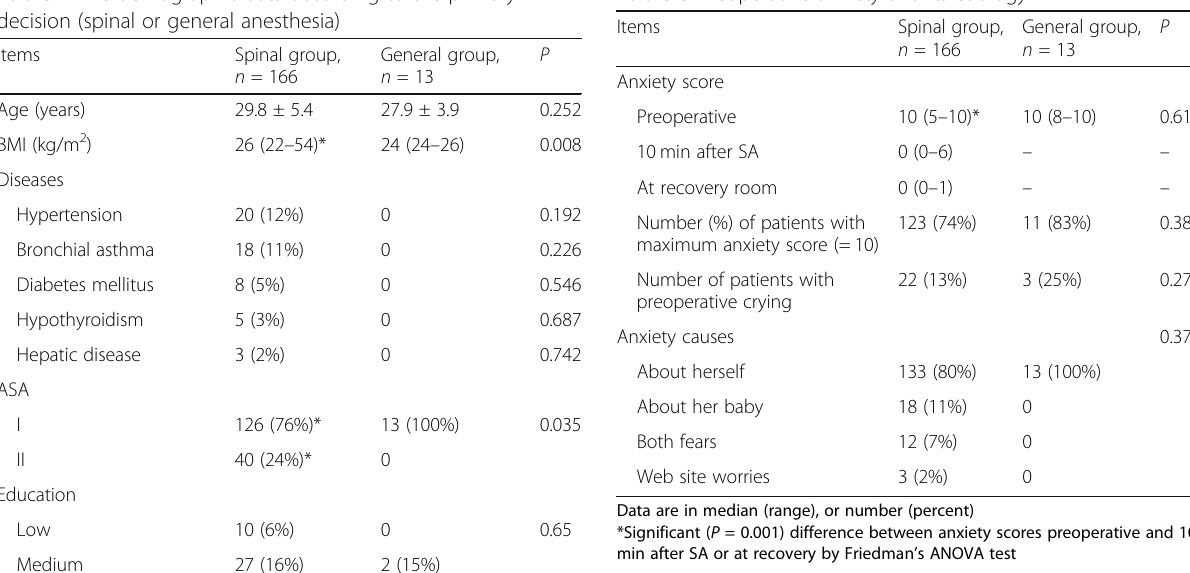
Table 1 The demographic data according to the primary